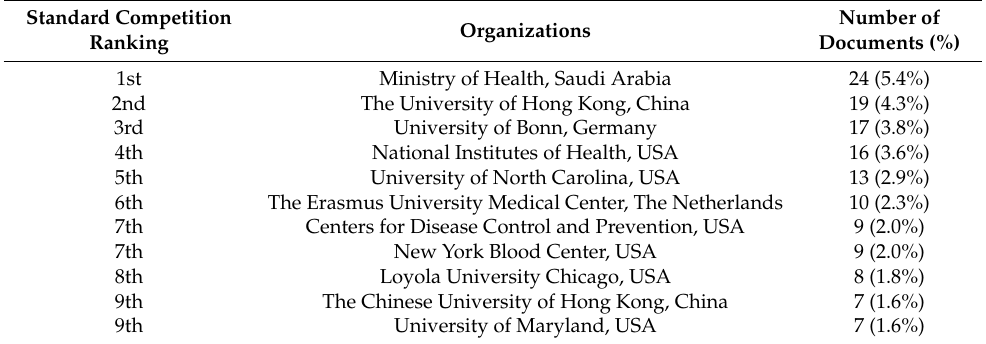
Table 4. Ten most productive organizations with MERS articles during the period from 2012 to